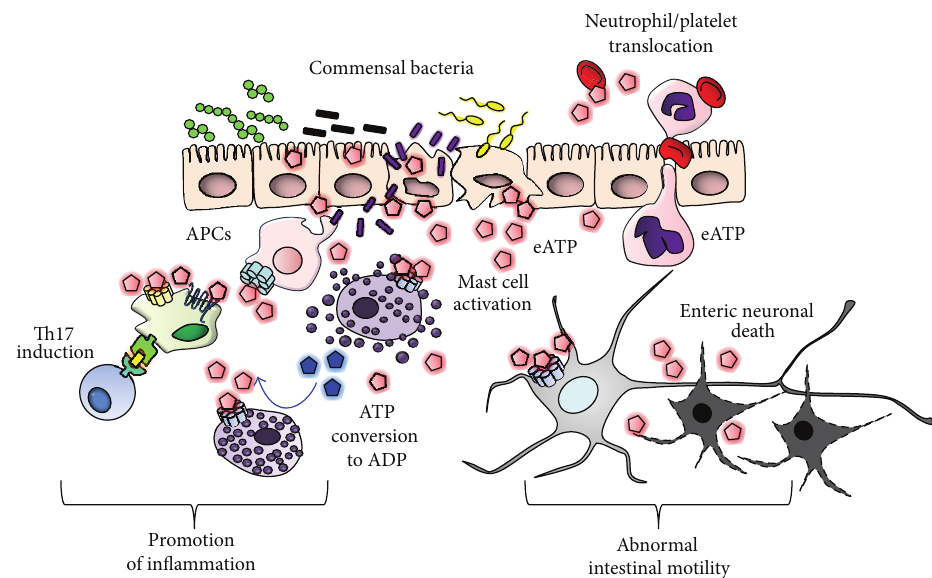
Figure 2: In the intestinal compartment, extracellular ATP (eATP) is released from damaged epithelial cells and commensal bacteria. Macrophages, platelets, mast cells, and neutrophils are potential source of eATP upon their activation. Neutrophils facilitate translocation of platelets across intestinal epithelium. eATP also induces Th17 cell generation, activation of mast cells, and neuronal cell death, promoting intestinal inflammation. APCs: antigen-presenting cells. eATP stimulates mast cells to induce the production of inflammatory chemokines (e.g., CCL2, CCL4, CCL7, CXCL1, and CXCL2), cytokines (IL-1 𝛽 , IL-6, and TNF 𝛼 ), and mediators (histamines and